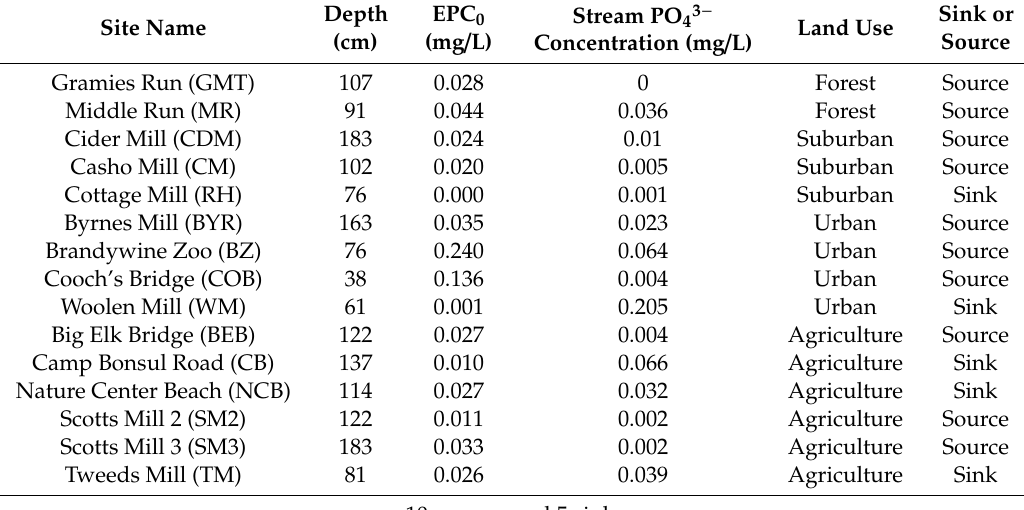
Table 3. Sediment EPC 0 concentrations for the 15 streambank legacy sediment sites (one selected depth) and comparisons against baseflow stream water PO 43 − concentrations to determine if sediments would act as a source or sink for P.